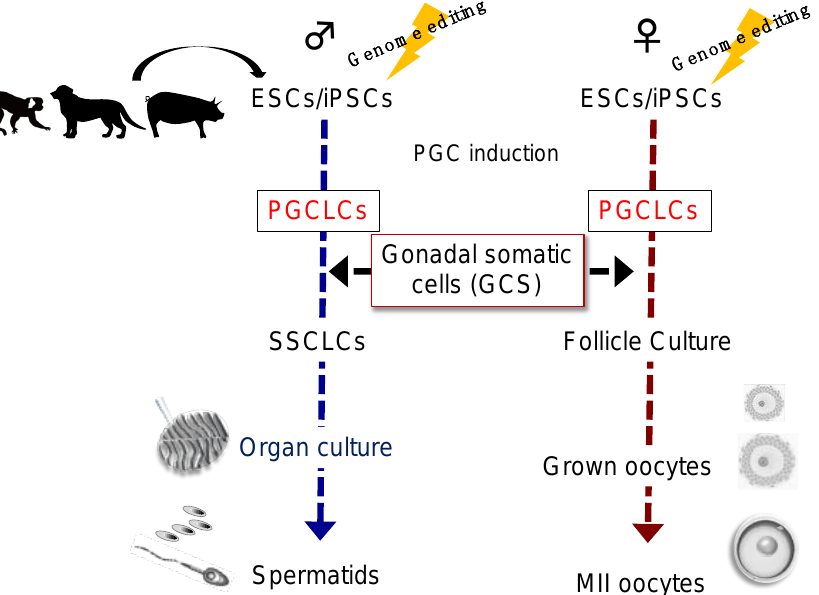
Figure 3. A graphical schematic of in vitro gametogenesis from large animal PSCs. Genome editing (introduction of PGC/mature germ cell reporters) is useful in ESCs/iPSCs for visualizing the differentiation. Cartoons of large animals (monkey, dog, and pig) were obtained from the graphical abstract of our previous study [40].